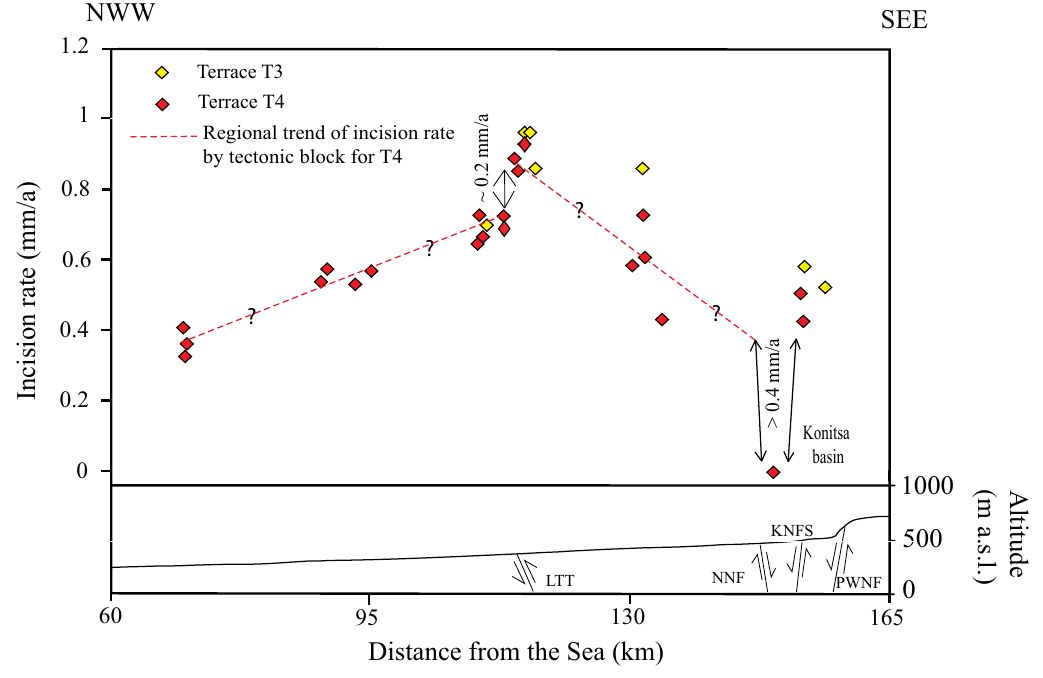
Figure 12. Evolution of the incision rate along the river profile of the Vjosa. In the Konitsa basin the correlative deposit of terrace T4 is lo- cated in the present river-bed. In the river profile are located the Lushnje-Tepelenë Thrust (LTT), Nerotrivi Normal fault (NNF), Konitsa Nor- mal Fault System (KNFS) and Papingo West Normal Fault (PWNF).